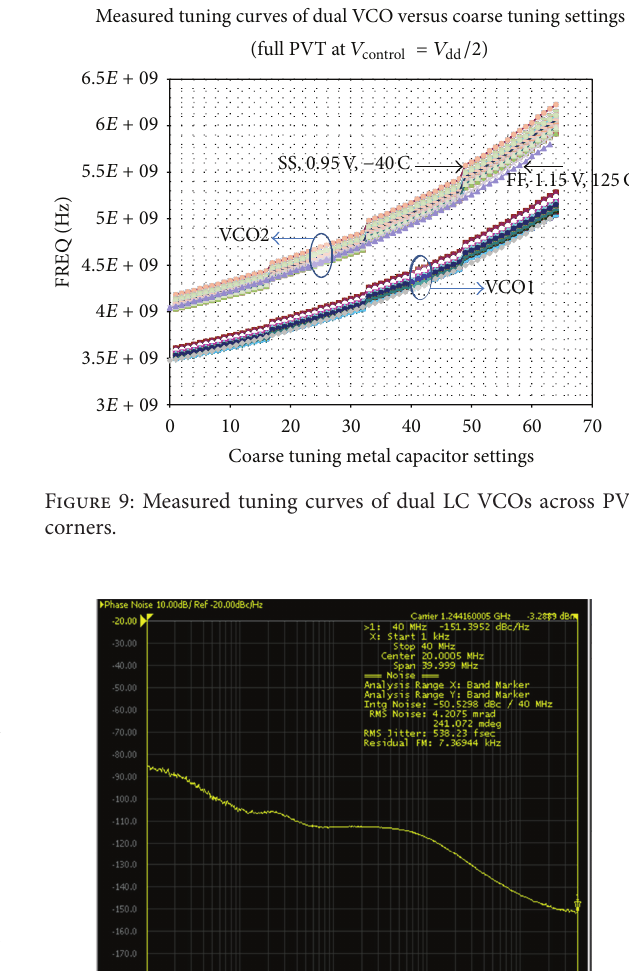
= 4.976 GHz); RJ = 538 fs VCO